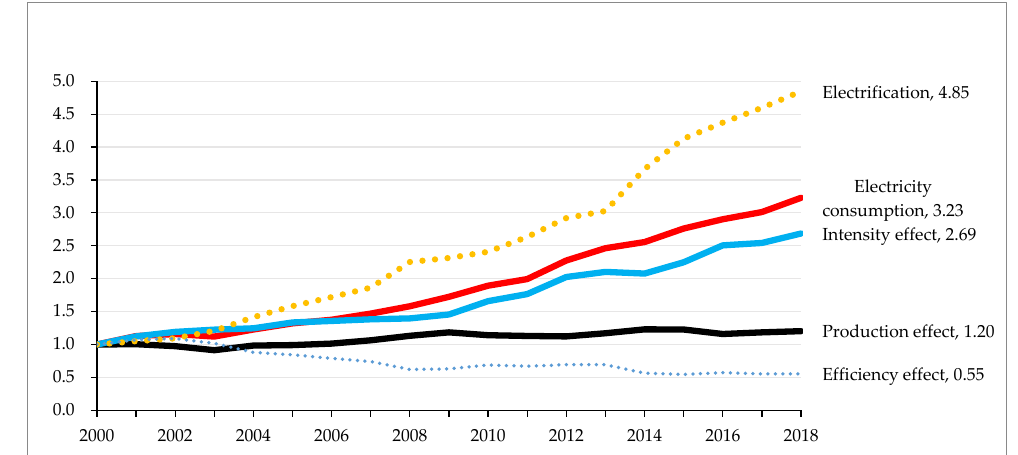
Figure A8. Fabricated metal electricity consumption LMDI results (fixed base year, multiplicative).